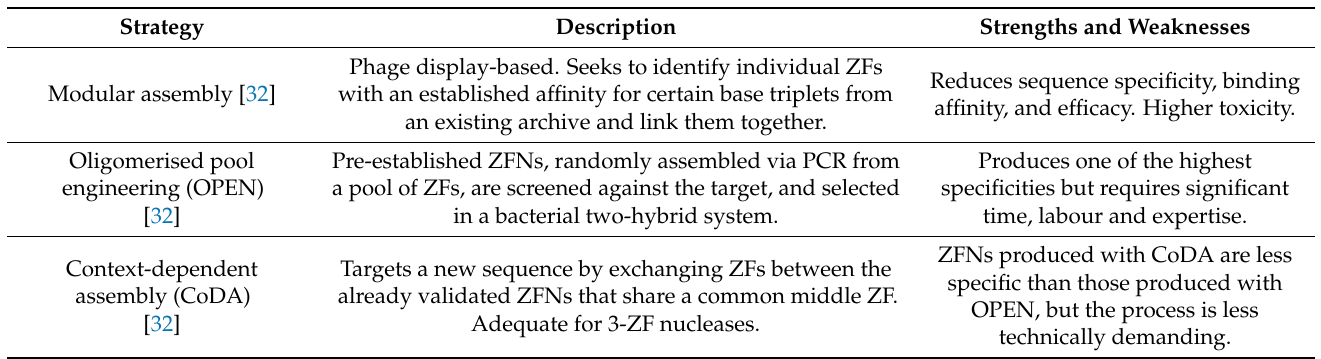
Table 2. Strategies for the assembly and selection of new ZFNs.